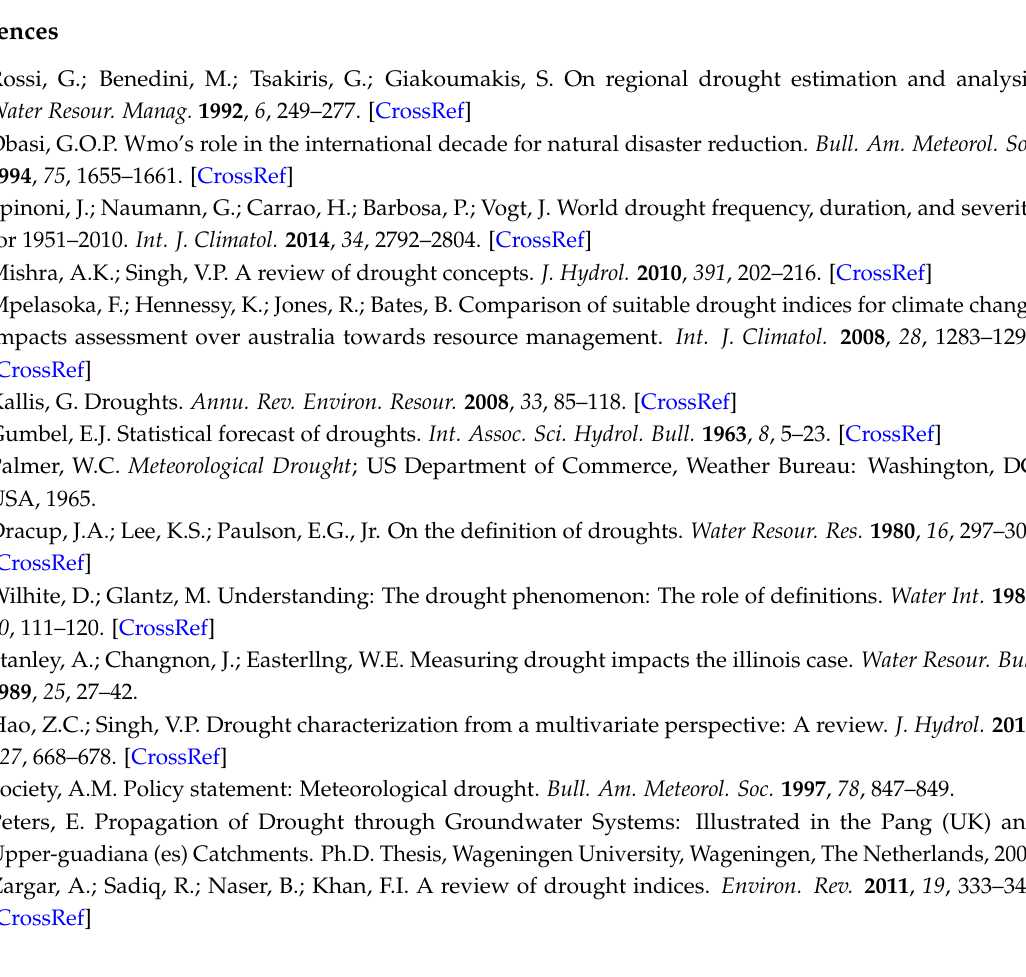
Table S1: Characteristics of the meteorological station, Figure S1: Time series of drought severity obtained with two different processing schemes for the Poyang Lake Basin in